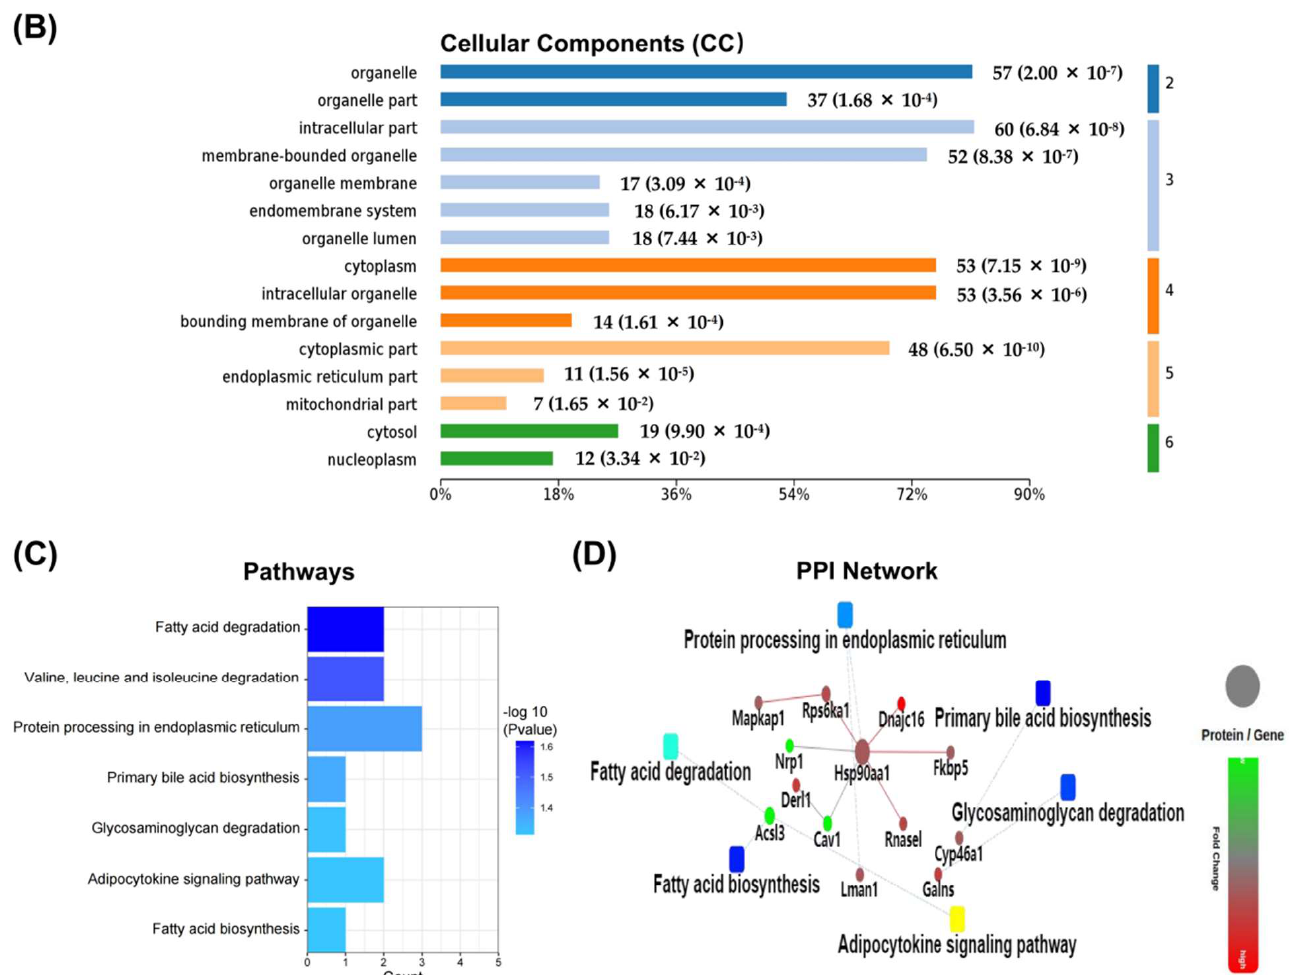
Figure 5. Bioinformatics analysis of the differentially expressed proteins in the As + DIP/As group. ( A ) The top 15 categories of enriched BP associated with DEPs. ( B ) The top 15 categories of enriched CC associated with DEPs. ( C ) The significantly enriched KEGG pathways linked to DEPs. ( D ) Path- way PPI network linked to the differentially expressed proteins in the As + DIP/As group. ( A – C ) The number of proteins and p -values is shown to the right of each term bar.